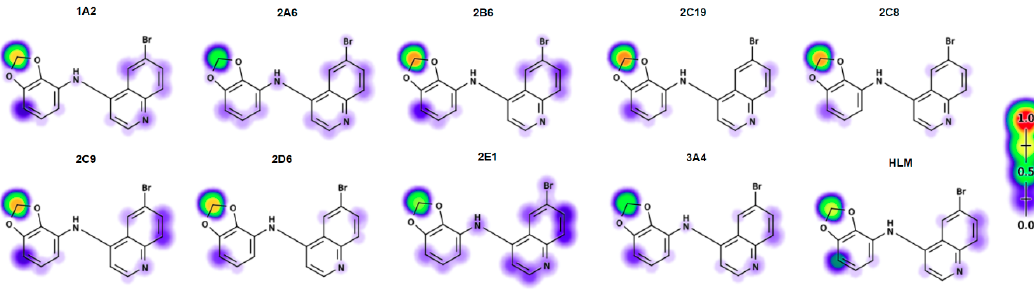
Figure 10. Compound 9 in XenoSite’s P450 Metabolism P450 1.0 algorithm.